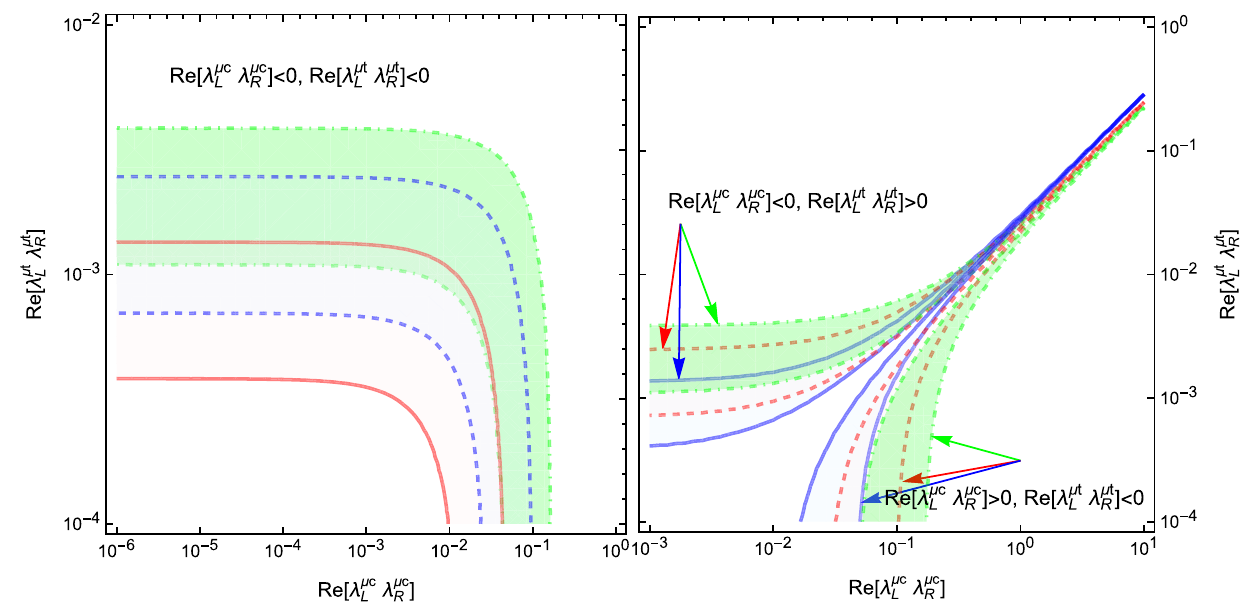
Fig. 6 Allowed regions with 95 % C.L. of the parameter space of our LQ model assuming that the contributions of LQ Ω 5 / 3 along with the c and t quarksareresponsibleforthemuonanomalousMDMdiscrepancy Δ a μ . We show the allowed region in the Re plane for two values of m Ω